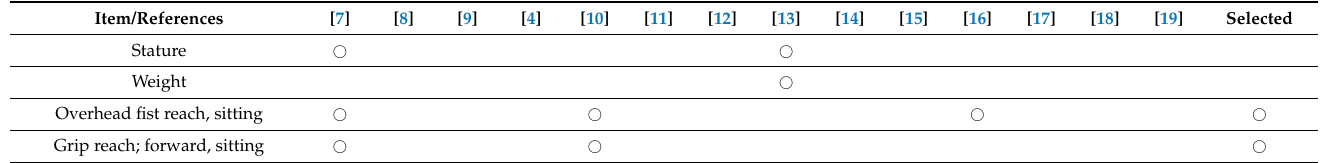
Table 1. Deriving the measurement